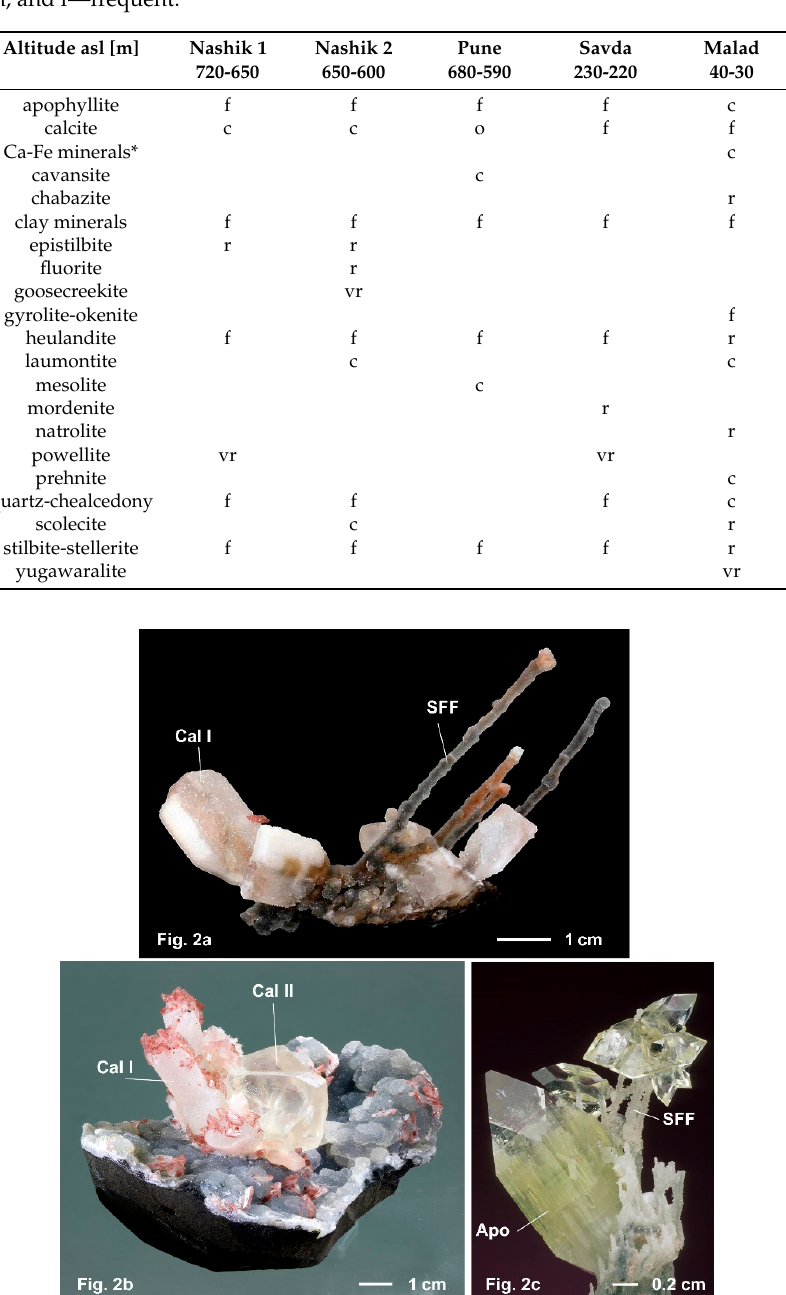
Table 1. Frequency of secondary minerals in cavities of di ff erent occurrences within the DVP: Nashik